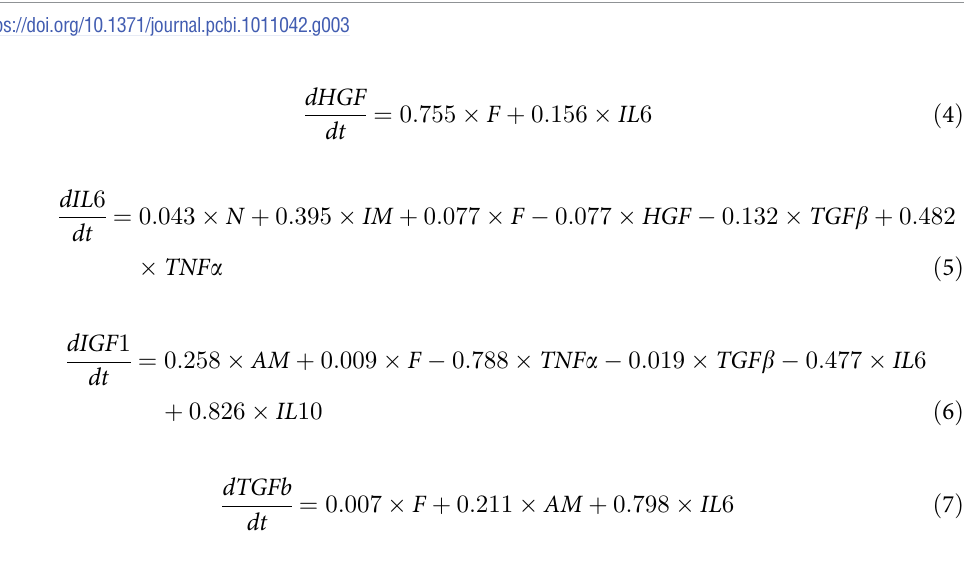
Fig 3. Simulation fibroblast count compared to reference fibroblast count at 0, 48, 168 and 672 hours post exercise induced